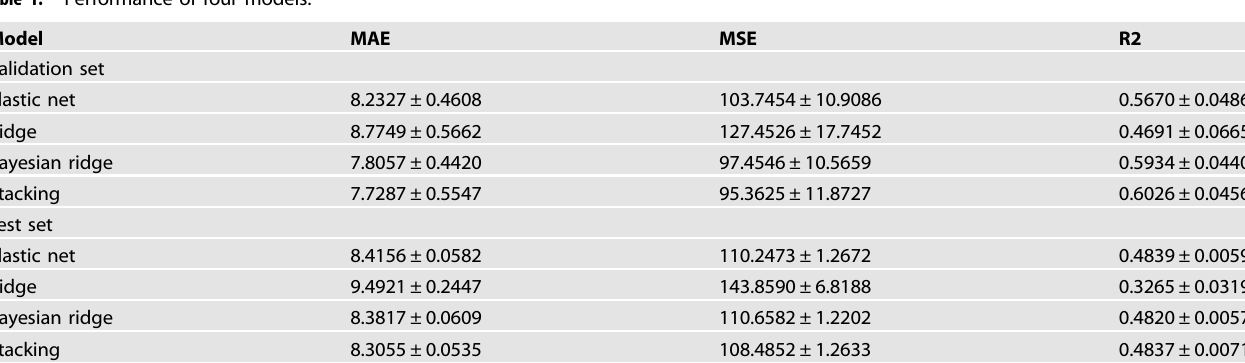
Fig. 1 The fl ow chart of the analysis. Time series for each subject are extracted from rsfMRI according to the AAL atlas. The Pearson correlation is used to get the functional connectivity matrix. Next, the upper triangle of the functional connectivity matrix is stretched into a one-dimensional vector to get each subject ’ s feature vector. The feature vectors are concatenated to obtain input data matrices. A brain age prediction model is trained and fi ve-fold cross-validated on the training set. Finally, brain-PAD scores are obtained by applying the model in the hold-out validation set and test Table 1. Performance of four models.